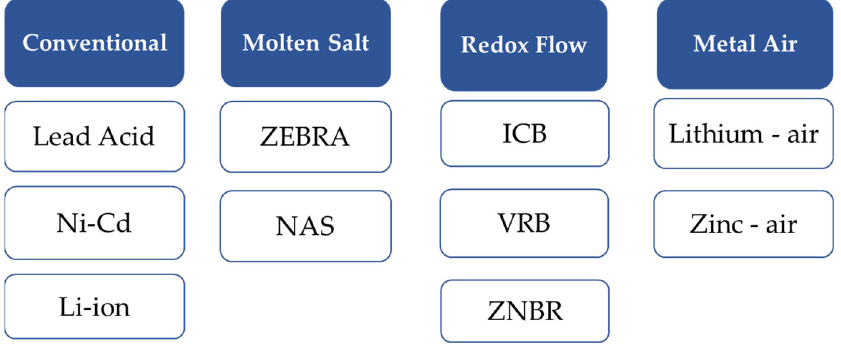
Figure 4. General classification of battery technologies.